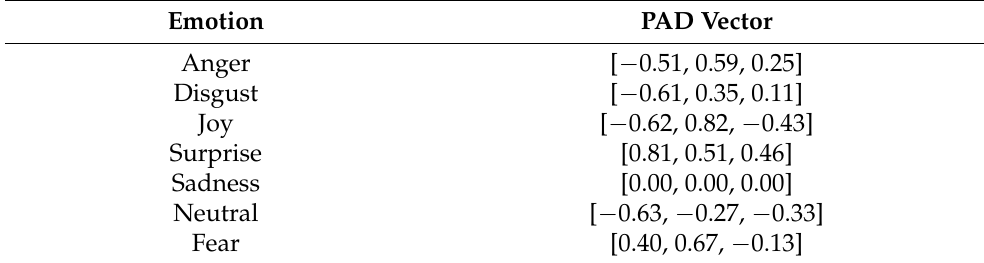
Table 1. Seven PAD emotion